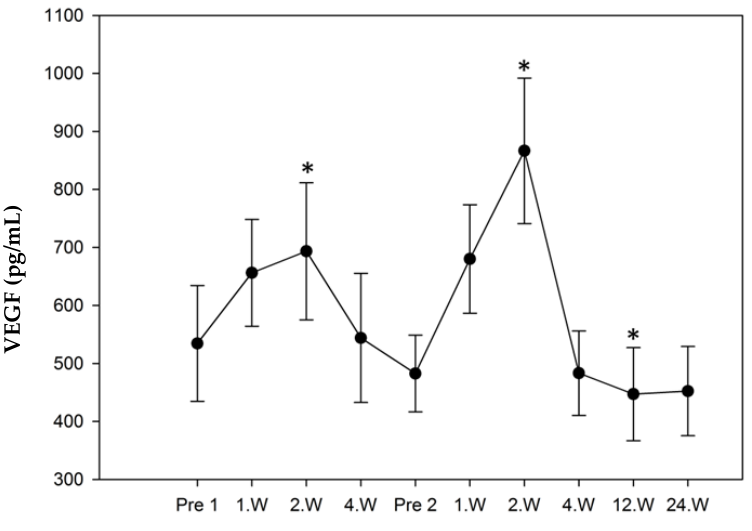
Figure 5. VEGF mean concentrations in non-responders over time (error bars: standard error of the mean, * significant p < 0.05, ** very significant p < 0.01), all values compared to Pre 1 (preoperatve value prior to step 1). VEGF levels were significant higher in the second week after step 1 and step 2. Maximum concentration of VEGF at second week after step 2.